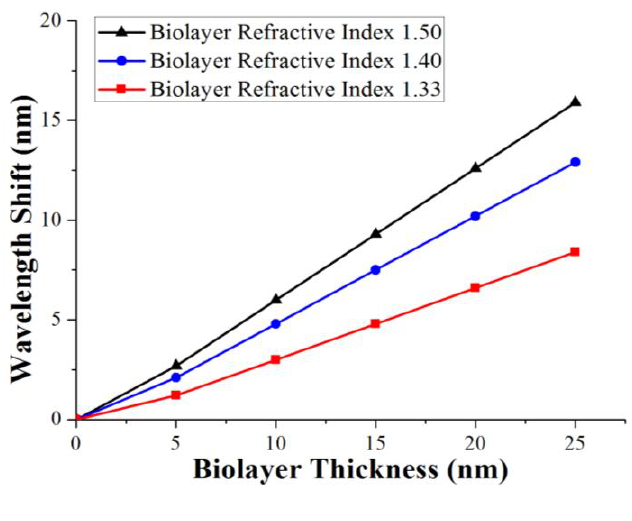
Figure 9. The phase shift with different biolayers thickness in nanometer level. Each of the three conditions has a linear phase shift response to the bonded biolayer